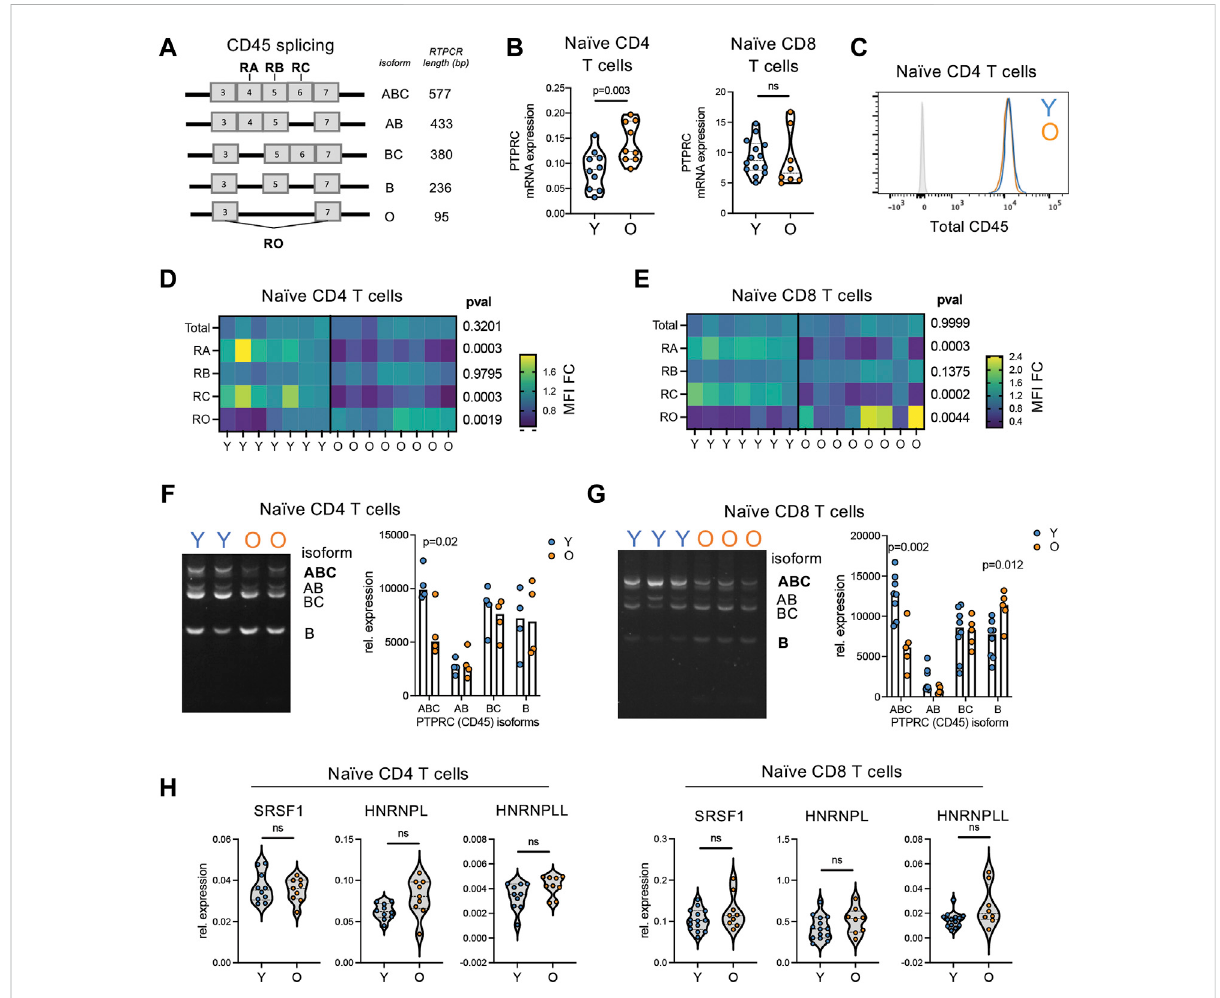
FIGURE 8 Reductions in CD45RA is caused by alternative splicing of CD45 not total protein loss. (A) Overview of CD45 isoforms. Bold indicated which exonsspeci fi cantibodiesbindto. (B) RNAexpressionofCD45(PTPRC)inbulknaïve(CD45RA+CCR7+)CD4andCD8Tcellsfromyoung( n =10)and older( n =9) adults. (C) Representative fl owhistogram ofCD45 proteinexpression on naïveCD4 Tcellsfromayoung (blue) andolder (orange) adult. Gray is negative control. (D) Naïve CD4 and (E) naïve CD8 T cell expression of total protein levels for CD45, CD45RA, − RB, − RC, and − RO in young ( n =7) andolder ( n = 8)adultsdetected byantibody. (F) NaïveCD4 and (G) naïve CD8 Tcell expressionof CD45isoforms via RT-PCRanalysis. Cell input was normalized for total CD45 expression. CD45RO isoform expression was too low in naïve T cells to be accurately quanti fi ed. (H) Expression of potential CD45 splice factors in naïve CD4 and CD8 T cells from young ( n = 10) and older ( n = 9) adults. p -values determined by (B,D,E,H) Mann-Whitney test and (F,G) unpaired t